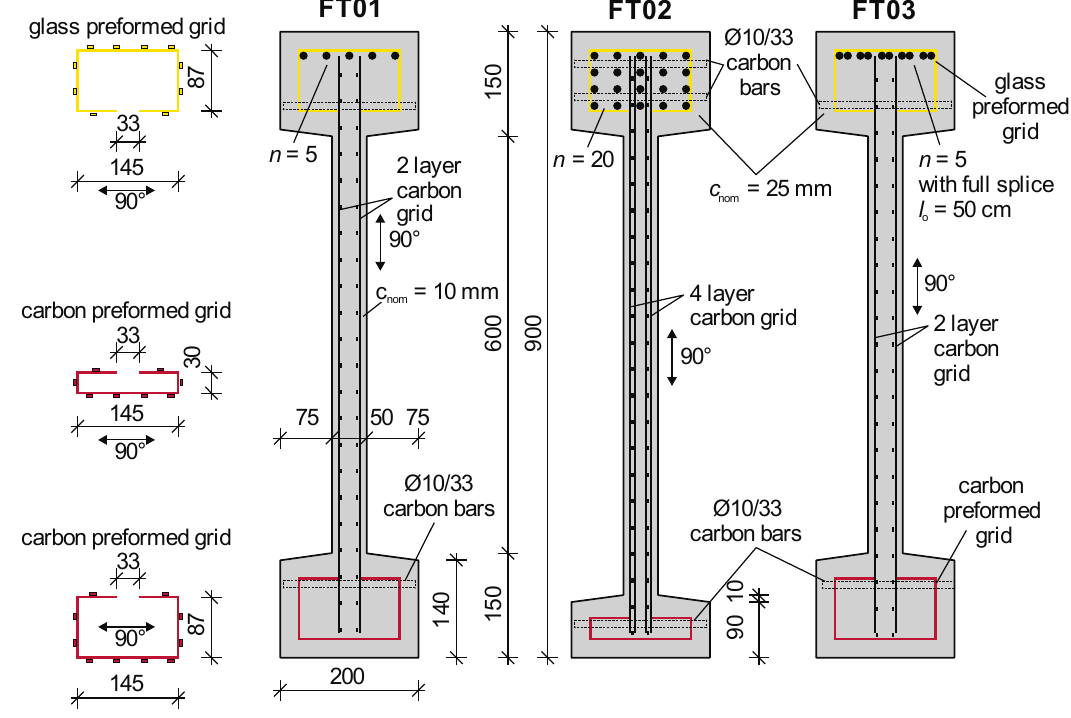
Figure 5. Cross ‐ sections and reinforcement layout of beams FT01–FT03 in mid ‐ span. Figure 5. Cross-sections and reinforcement layout of beams FT01–FT03 in